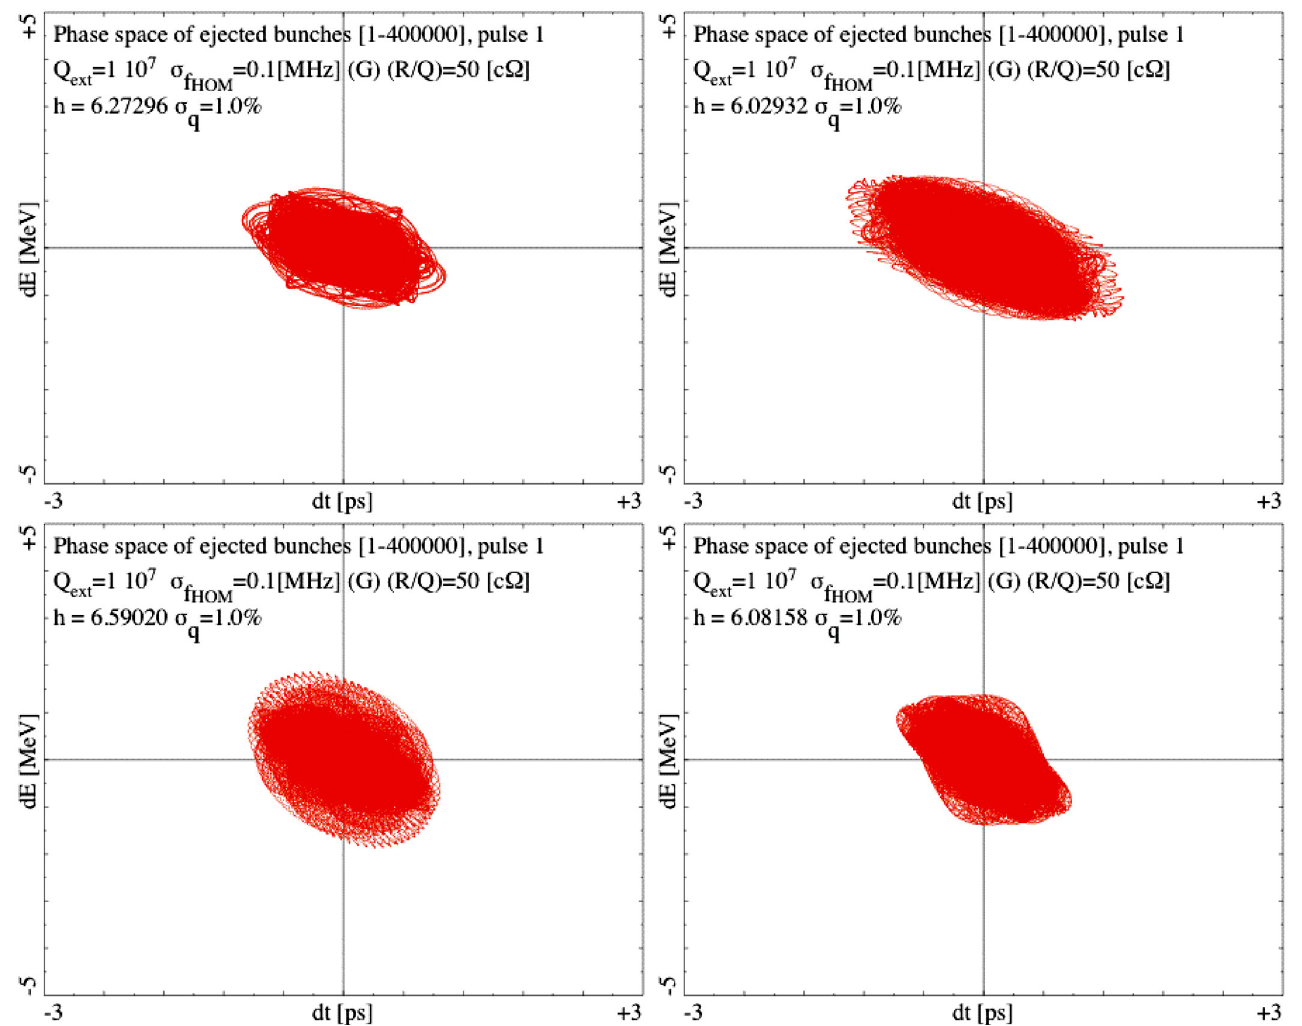
FIG. 15. (Color) Phase-space plots for four random HOM center frequencies h f H i (between h ¼ 6 and 7) but identical f H scatter and bunch-charge sequence. Scaling ½(cid:3) 3 ps (cid:4) (cid:8) ½(cid:3) 5 MeV (cid:4)